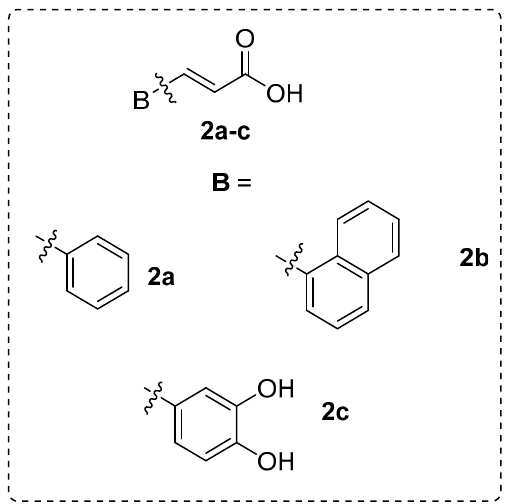
Figure 4. The selected cinnamic acids.